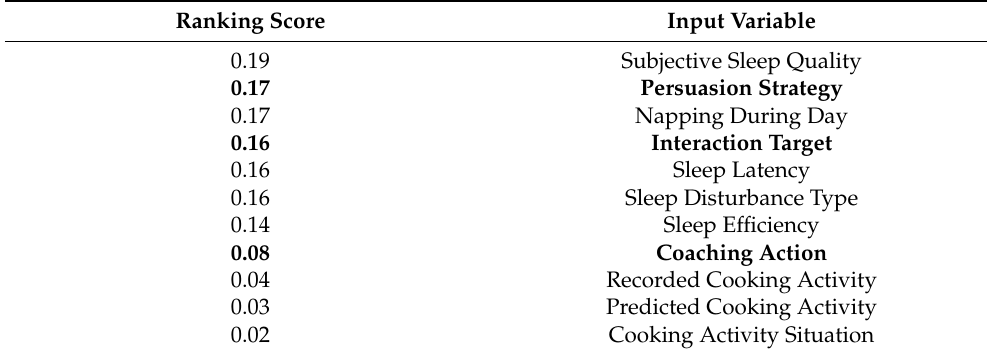
Table 2. Ranking of the input variables with the random forest method for user acceptance of the sleep quality coaching actions. PLTs are typeset in